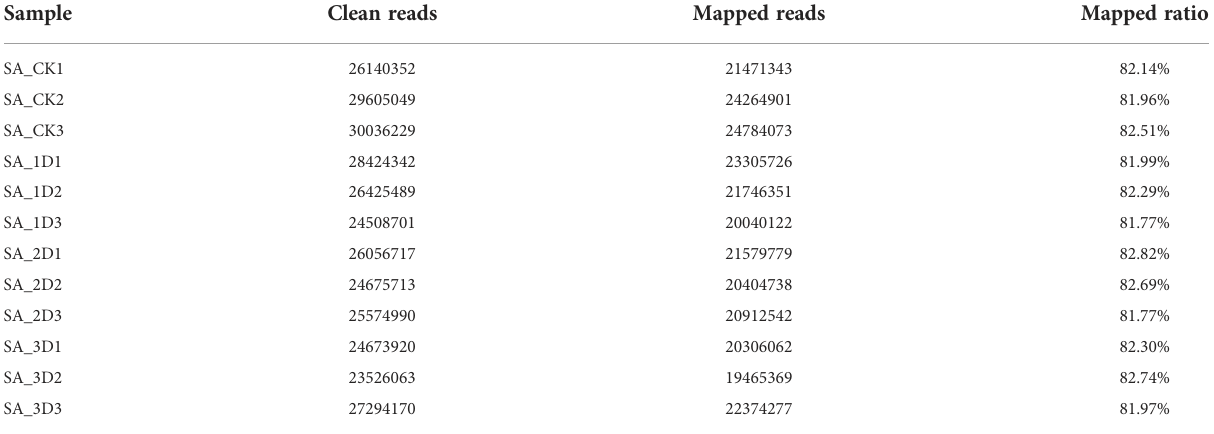
TABLE 3 Comparison of sequencing data and assembly results.